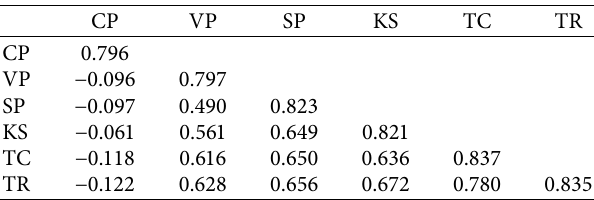
Table 4: Construct correlations. Table 5: Linear direct effect